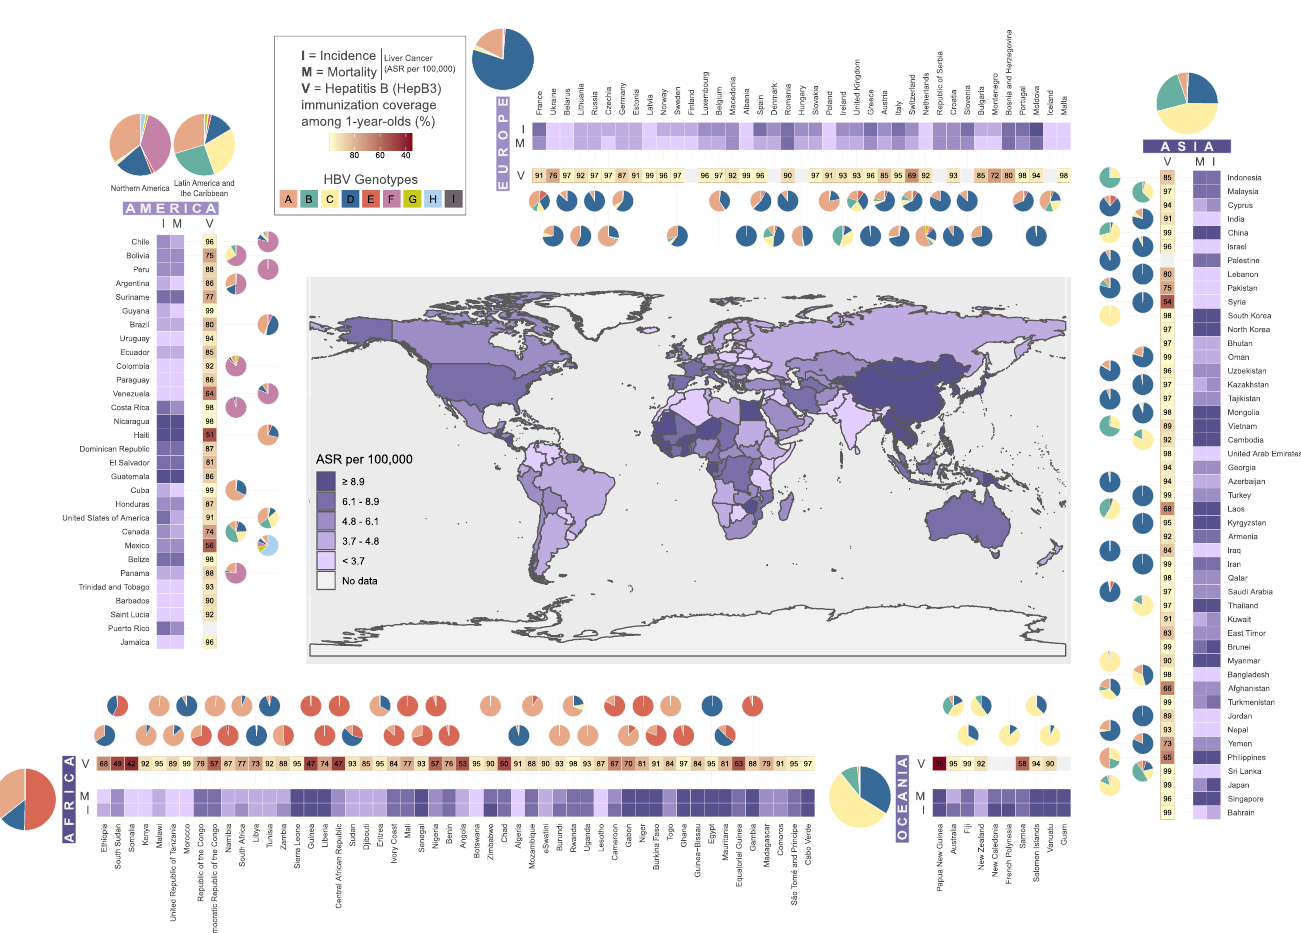
Figure 1. Geographical distribution of liver cancer incidence and mortality rates (Age-Standarized Rate-ASR per 100,000— data derived from WHO-Global Cancer Observatory: Available online: gco.iarc.fr (accessed on 8 May 2012)), percentage of Hepatitis B (HepB3) immunization coverage among one-years-olds (data derived from WHO–Global Health Observatory data repository: apps.who.int/gho/data/view.main.80300 accessed on 18 August 2021) and HBV genotypes (data derived from Velkov et al. [36]). The world map has been colored with respect to the Liver Cancer Incidence Rate (ASR per 100,000). The ASR Incidence and Mortality as well as the percentage of the HepB3 immunization coverage among one-years-olds are depicted as a heatmap, while the pie charts represent the proportional (%) HBV genotype distributions in the respective countries. All plots were generated using the ggplot2 R package